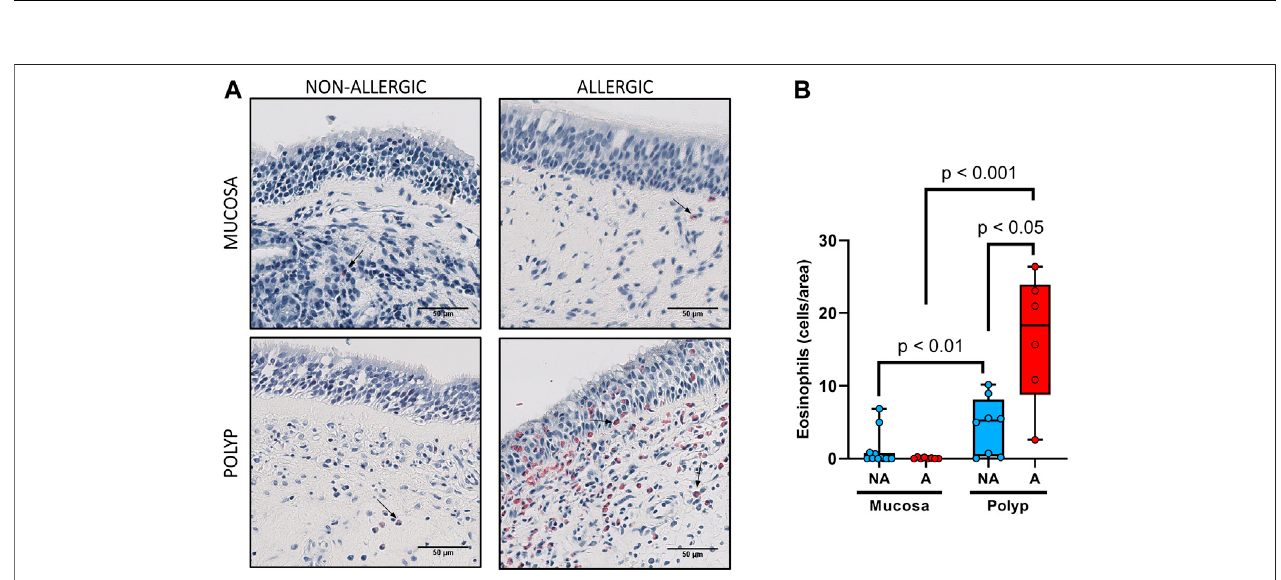
FIGURE 4 | Analysis of eosinophil in fi ltrates in nasal polyps and nasal mucosa. (A). Representative images of Luna staining in nasal mucosa ( n (cid:2) 20) and nasal polyps ( n (cid:2) 14) in all experimental groups (eosinophils: black arrow → , scale bar (cid:2) 50 μ m). (B). Comparison of the number of eosinophils per area in nasal polyps and nasalmucosasamplesbetweennon-allergicCRSwNP(NA)andallergicCRSwNP(A)patients.Resultsarepresentedasmean ± SEM.Mann-Whitney U testwasusedto state signi fi cant